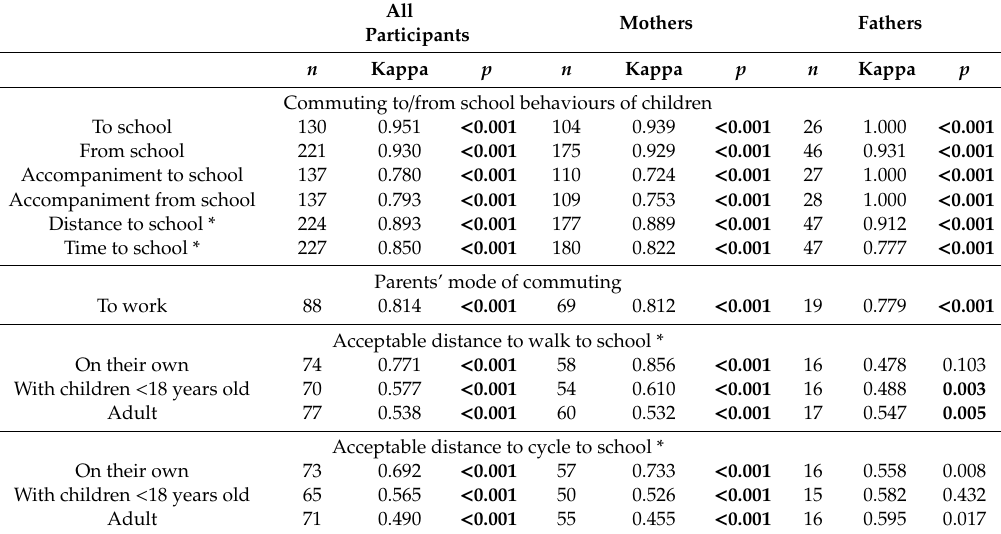
Table 4. Test–retest reliability coe ffi cients on commuting-to-school behaviours of children and fathers / mothers’ mode of commuting to